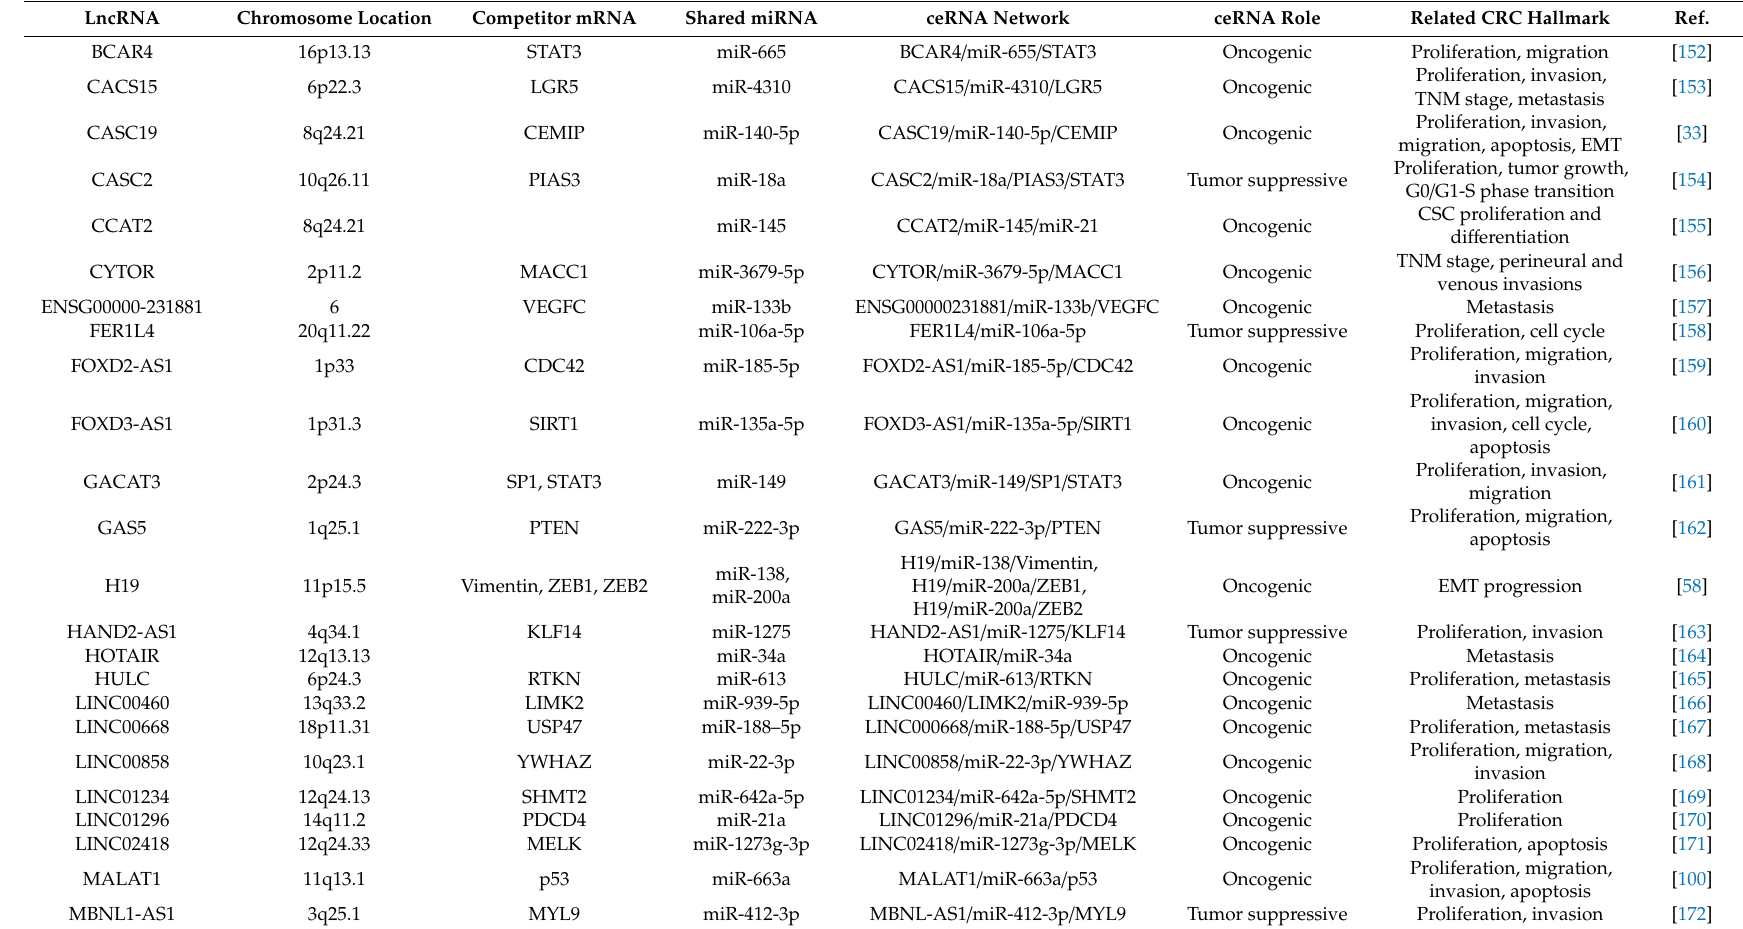
Table 1. LncRNA / miRNA / mRNA ceRNA network in